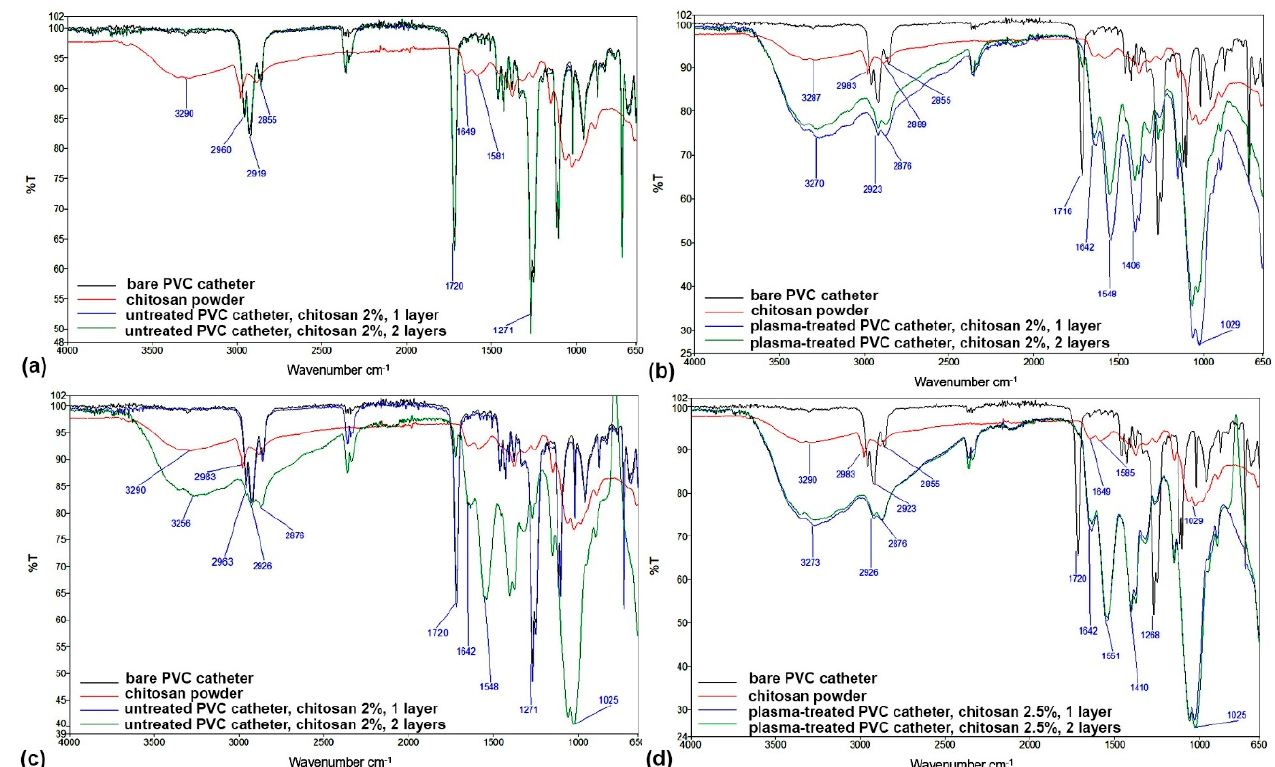
Figure 11. FTIR spectra of TPE catheters with chitosan coatings: ( a ) untreated catheter with one or two layers of the 2% chitosan coating, ( b ) plasma-treated catheter with one or two layers of the 2% chitosan coating, ( c ) untreated catheter with one or two layers of the 2.5% chitosan coating and ( d ) plasma-treated catheter with one or two layers of the 2.5% chitosan coating. In all subfigures, refer- ence spectra of the bare TPE catheter and chitosan powder were added.